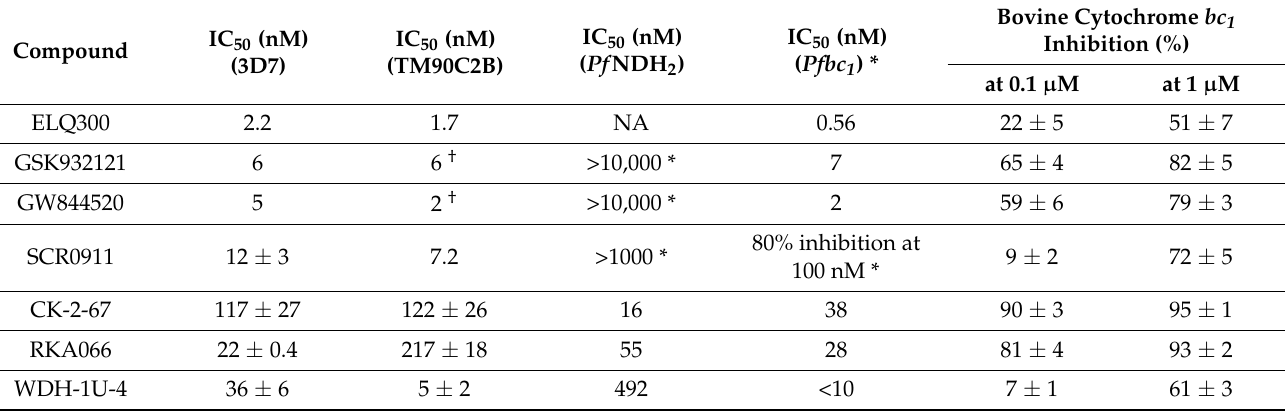
Table 1. Inhibition profiles of selected antimalarial compounds against whole cells of Plasmodium falciparum ( Pf ) (3D7 and TM90C2B strains) and individual mitochondrial